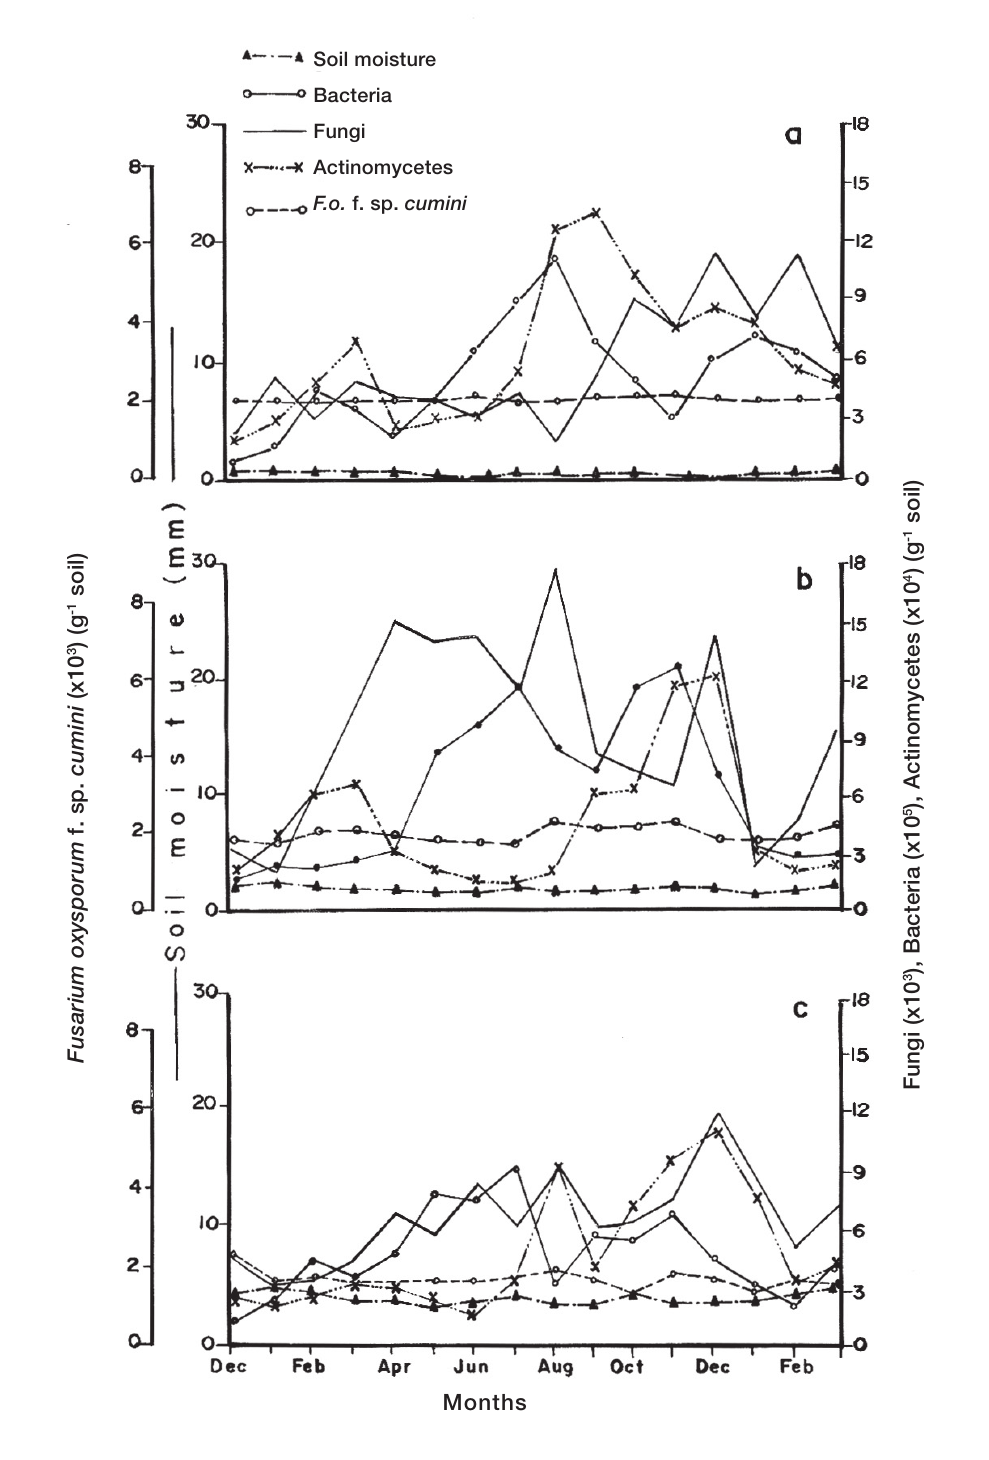
Fig. 3. Mean monthly levels of soil moisture, and presence of Fusarium oxysporum f. sp. cumini and other microbial populations at different soil depths in fallow fields (a) at 0–5 cm soil depth; (b) at 6–15 cm, and (c) at 16–25